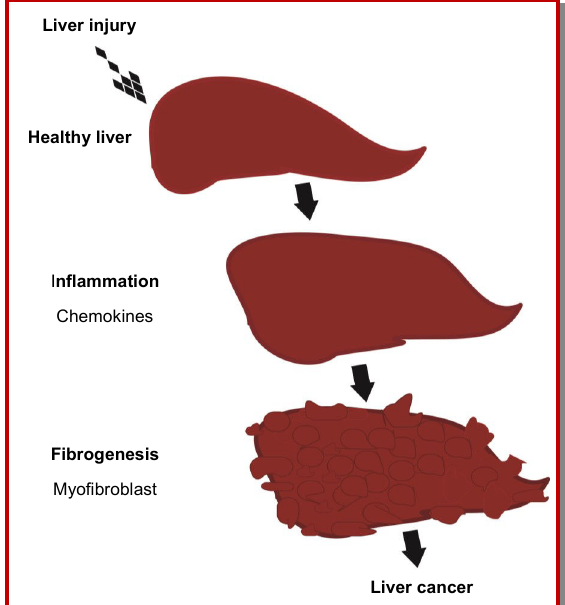
Figure 1: Progression of liver fibrosis which leads to cancer